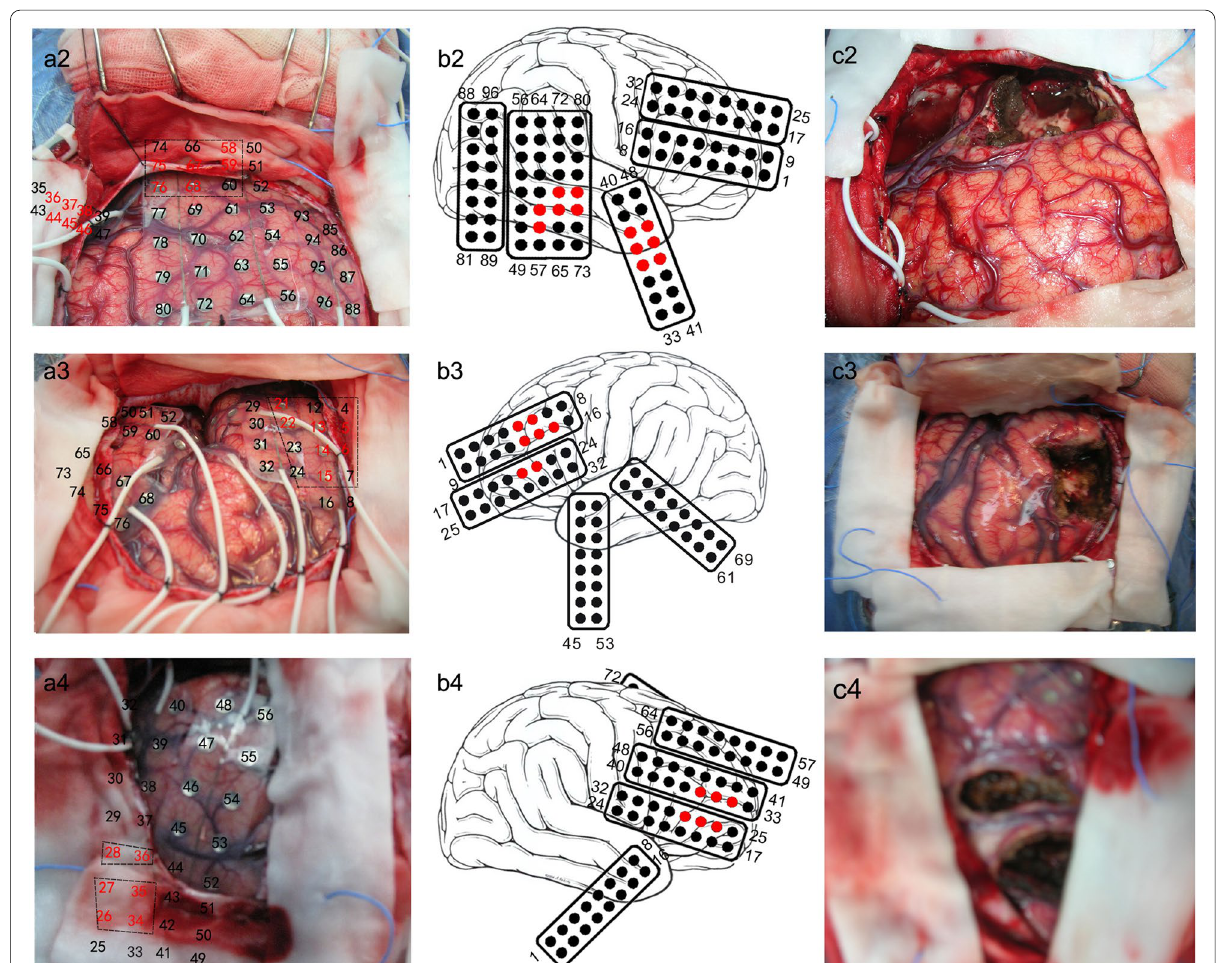
Fig. 3 Illustrations of electrodes and resected areas of patients 2–4 (Red numbers indicate the seizure onset areas according to ECoG analysis. Number 2–4 represent the patients 2–4. Red dots indicate seizure onset areas according to ECoG. Dashed lines show the resected areas during